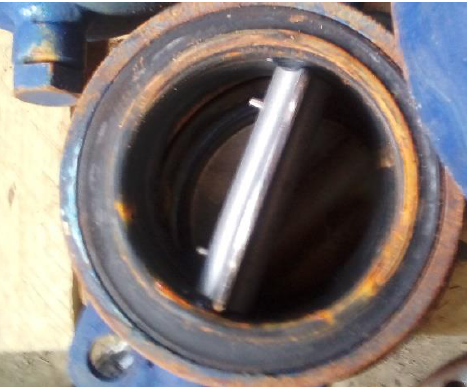
Figure 15. A heat supply system equipment (a valve) if geothermal water is treated with an acous- tic–magnetic device. magnetic device.